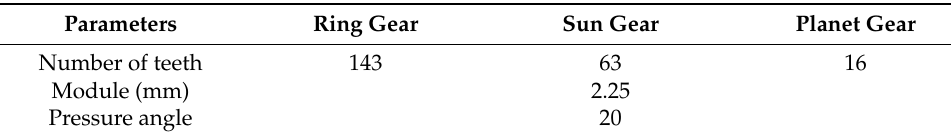
motor parameters are given in Table